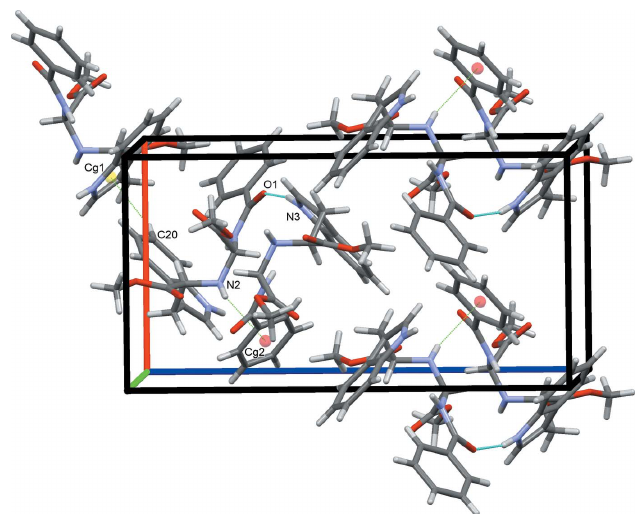
Figure 2 A view of the crystal packing of the title compound along the b axis. N— H (cid:3)(cid:3)(cid:3) O hydrogen bonds are drawn as blue dashed lines with N—H (cid:3)(cid:3)(cid:3) (cid:2) and C—H (cid:3)(cid:3)(cid:3) (cid:2) contacts shown as dotted green lines. Ring centroids are displayed as coloured spheres.